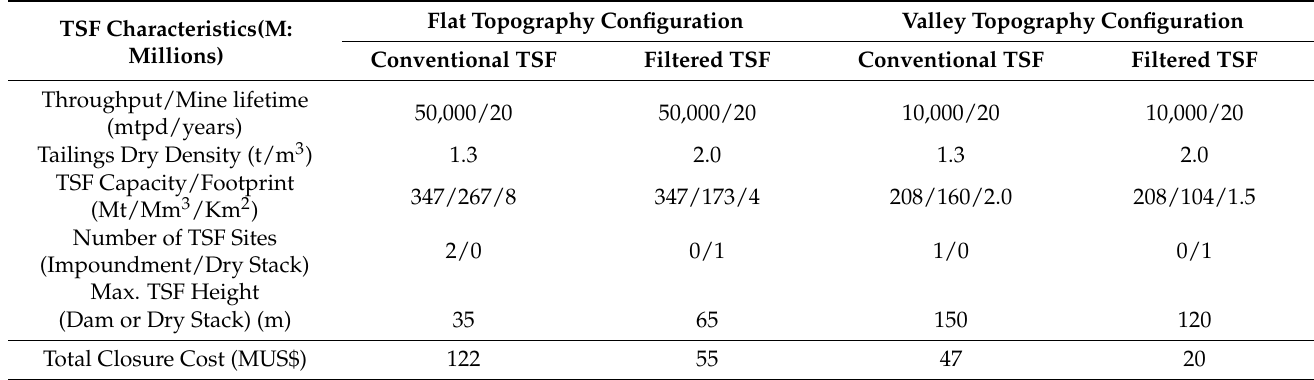
Table 4. Conventional/Filtered TSF Closure Cost Estimate–Comparative Analysis